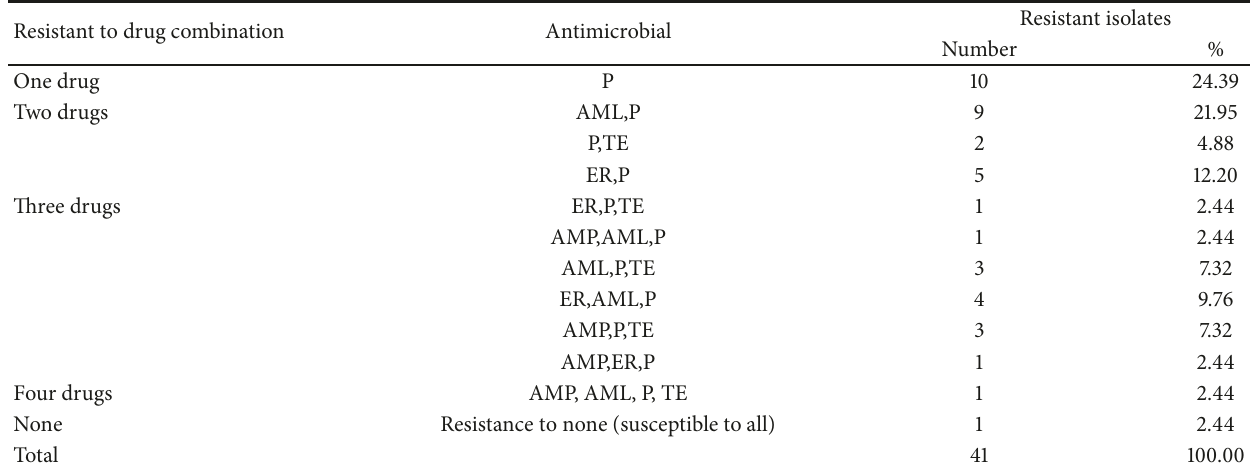
Table 8: Multidrug resistance combination of S. aureus